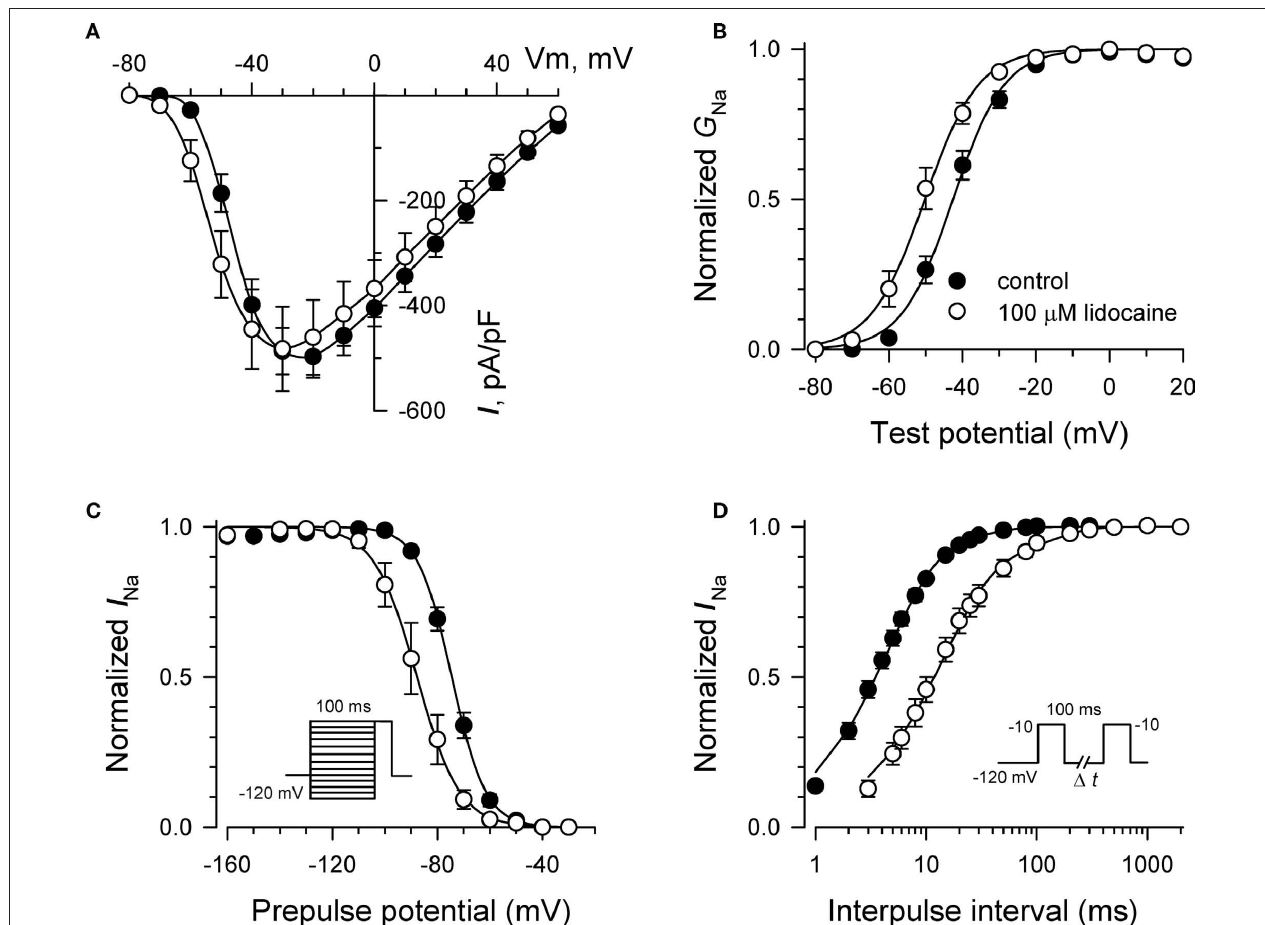
Figure 8 | Biophysical effects of lidocaine on NaV1.5-F1760A channels. (A) Current–voltage relationships in the absence and presence of 100 μM lidocaine. Peak current amplitudes were elicited from a holding potential of − 120 mV to various test potentials then normalized to cell capacitance. (B) Conductance–voltage relationship in the absence and presence of 100 μM lidocaine. (C) Voltage-dependence of sodium